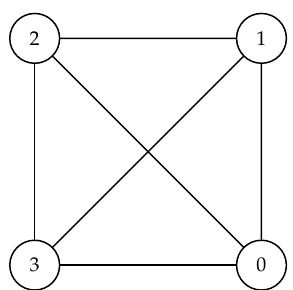
Figure 1. The above graph depicts the network G 1 consisting of three nodes plus the depot (node 0).